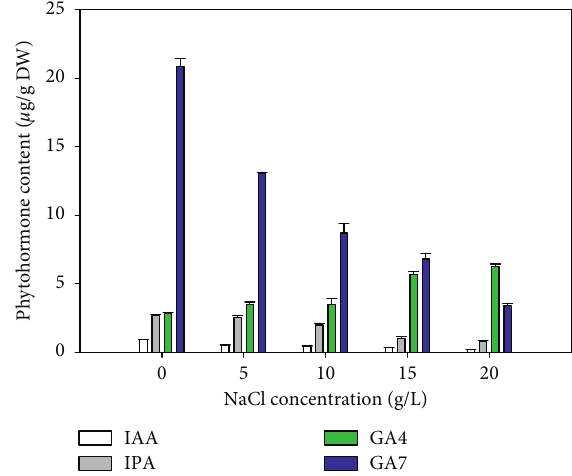
Figure 1: Profile and concentration of endogenous phytohor- mones produced by C. sorokiniana TH01 grown